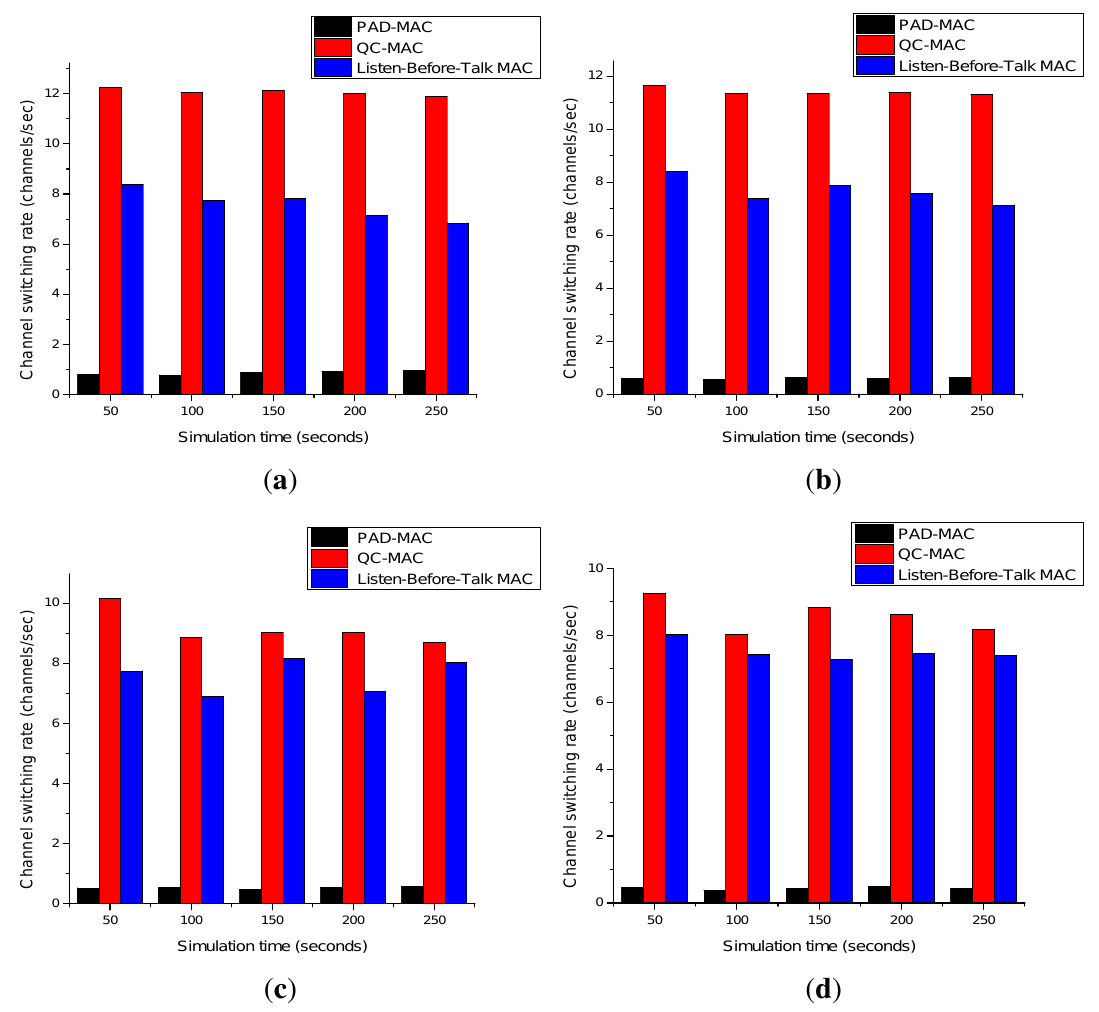
Figure 13. Channel switching rate. ( a ) Three channels; ( b ) five channels; ( c ) seven channels; ( d ) ten channels.